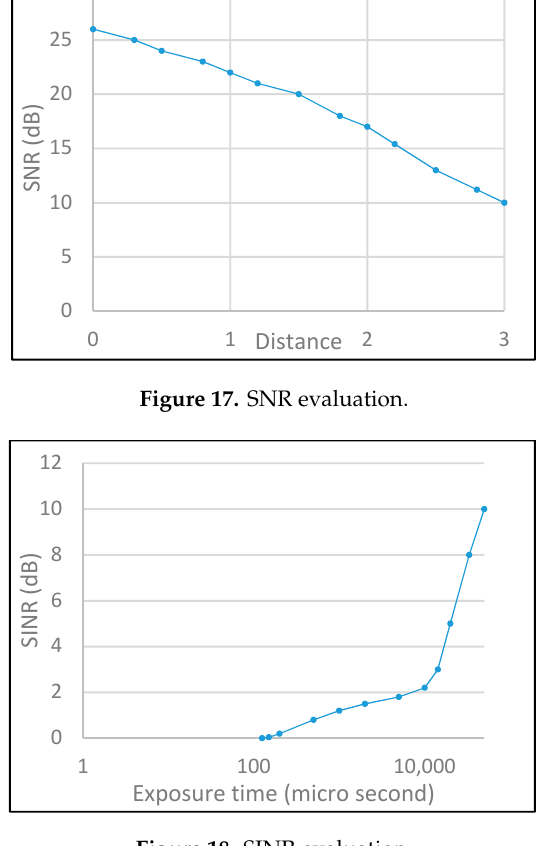
Figure 19. Transmitter implementation architecture. ( a ) Circuit diagram. ( b ) Devices demo. Table 3. Configuration of experimental implementation. Configuration Parameter